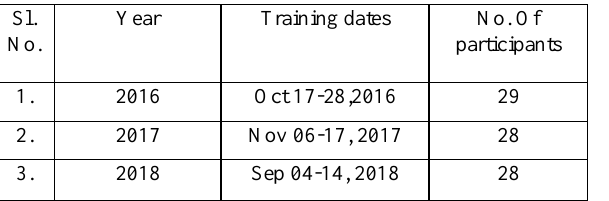
Table 1: Details of two weeks training course on UAV Remote Sensing Applications and Technological advancements